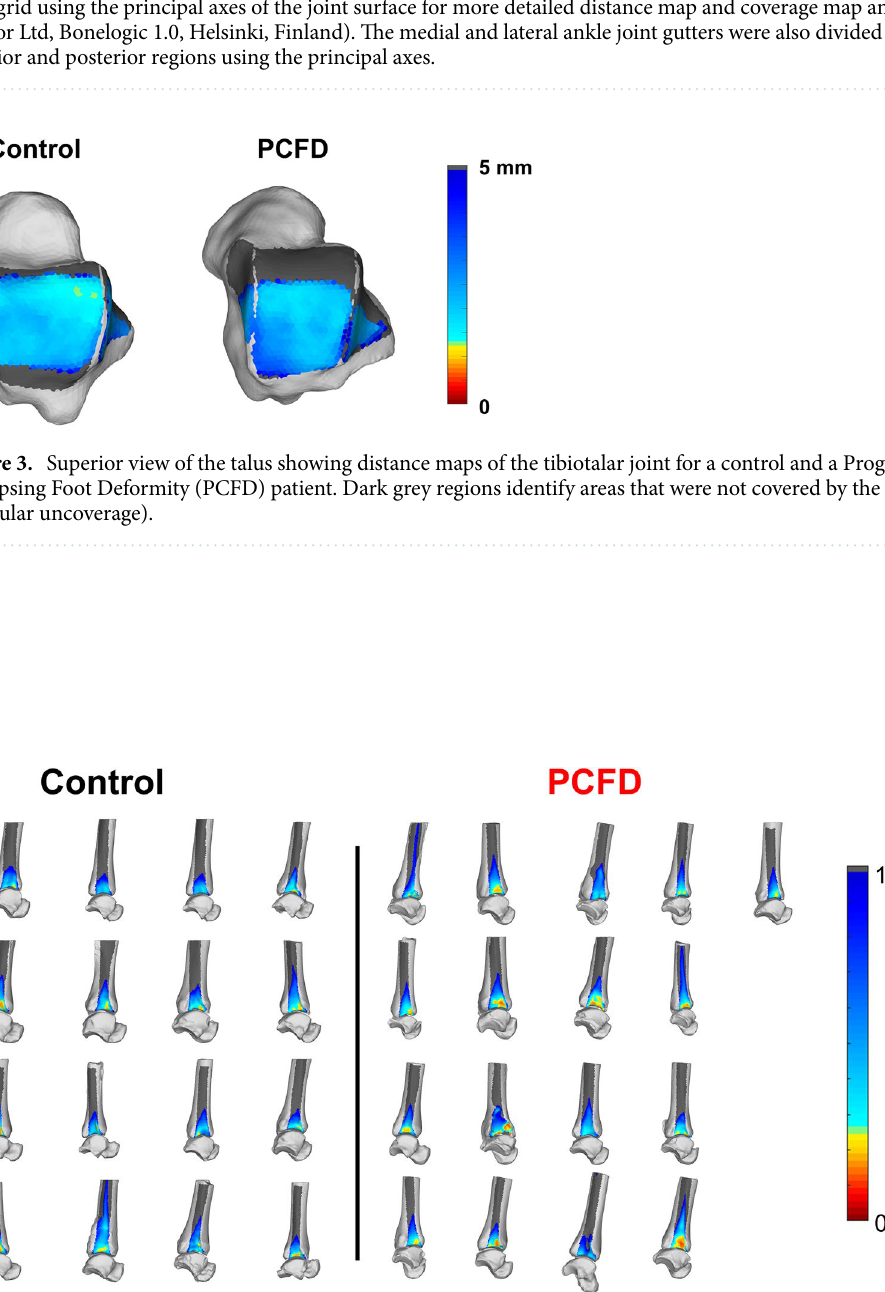
Figure 4. Distal tibiofibular syndesmotic colored distance maps (graded from 0 to 10 cm distances) for all control and Progressive Collapsing Foot Deformity (PCFD) patients are presented. Fibula was removed and distance maps are represented on the lateral aspect of the distal tibia. Dark grey regions identify distances > 10 mm where. Plantarflexion of the talus can be noticed on many PCFD